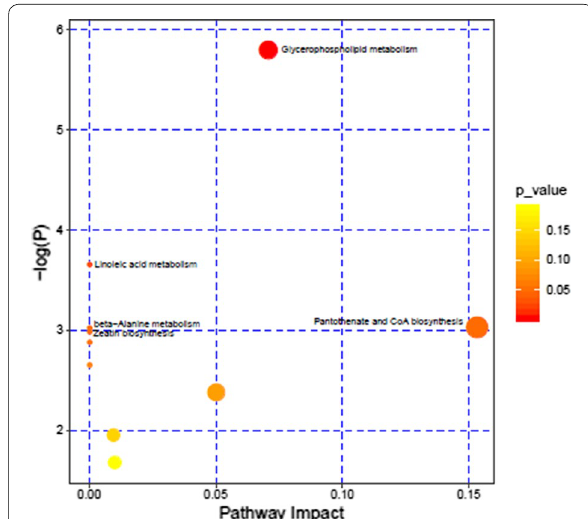
Fig. 5 Metabolome map of differential metabolites between CON and ART dairy cows. The x-axis represents the pathway impact, and the y-axis represents the pathway enrichment. Larger symbol sizes indicate higher pathway impact values and darker colors indicate lower P